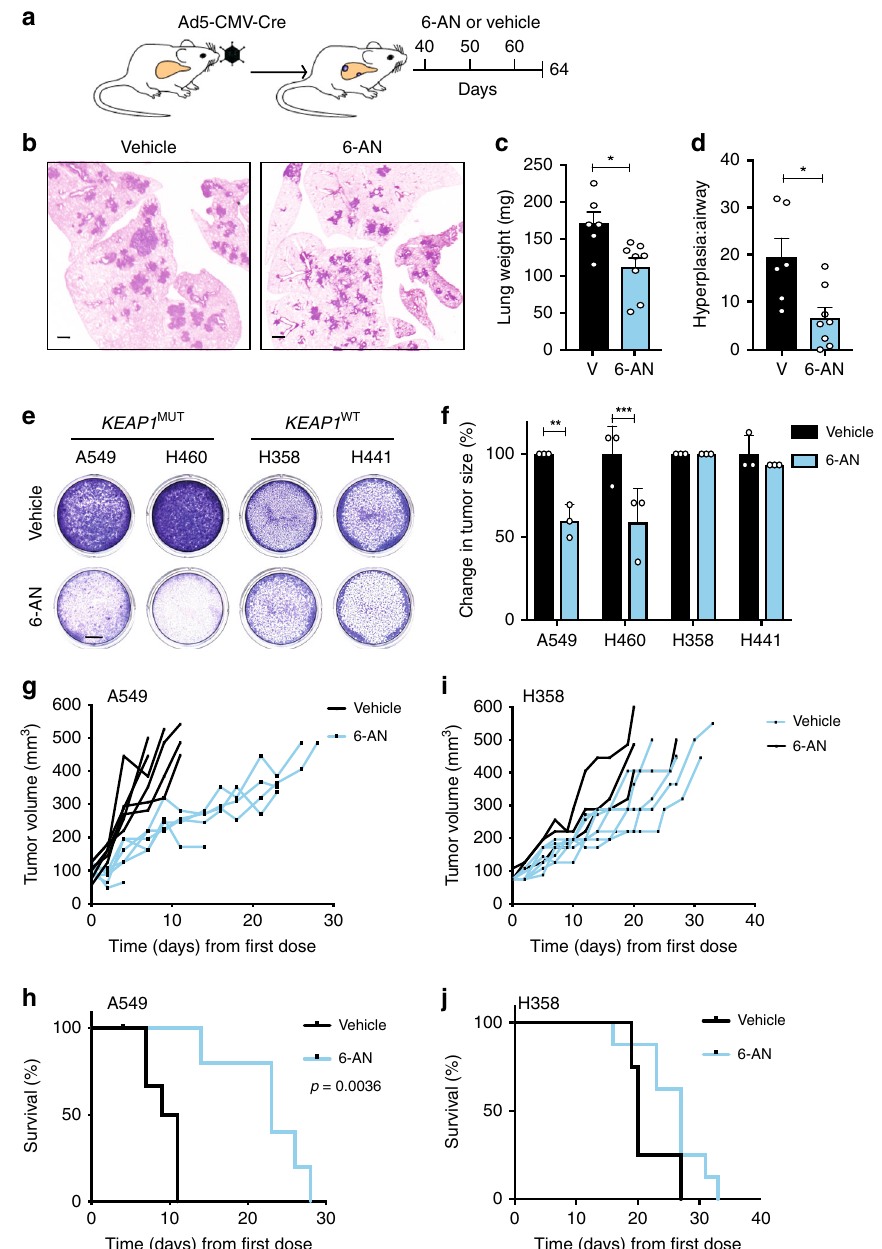
Fig. 7 PPP blockade abrogates the growth of KEAP1 -mutant LUAD. a Schematic of spontaneous tumor treatment study. Brie fl y, KK or KP mice were randomized into 20 mg/kg 6-AN or vehicle treated 40 days post Ad5-CMV-Cre intranasal infection. Lungs were harvested for analysis on day 64. b Representative H&E images of KK vehicle or 6-AN-treated lungs. Scale, 1 mm. c Quanti fi cation of KK superior lobe lung weight (milligrams, mg) following vehicle ( n = 6) or 6-AN ( n = 8) treatment. Unpaired t test * p = 0.0106. Mean ± SEM. d Ratio of KK hyperplasia relative to large airway size in vehicle ( n = 6) and 6-AN ( n = 8) treated lungs. Unpaired t test * p = 0.0116. Mean ± SEM. e Colony assay 72 h following treatment with 62.5 μ M 6-AN vs vehicle in KEAP1 MUT and KEAP1 WT NSCLC cell lines. Scale, 5 mm. f Relative change in tumor size of xenograft models ( n = 3/cell line) of KEAP1 MUT and KEAP1 WT